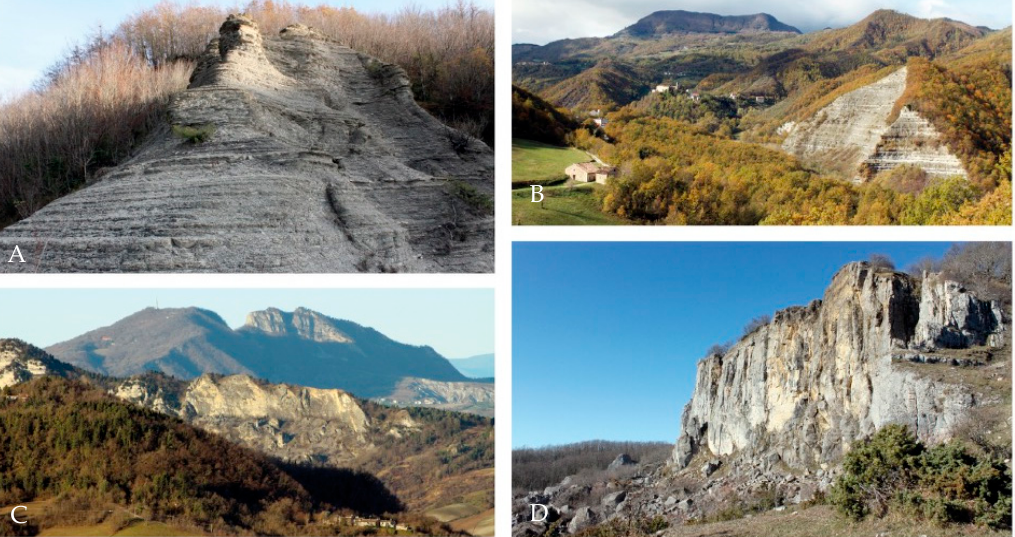
Figure 4. Warm-colored landscapes of Paesaggeo online survey: ( A ) Colorìo marls; ( B